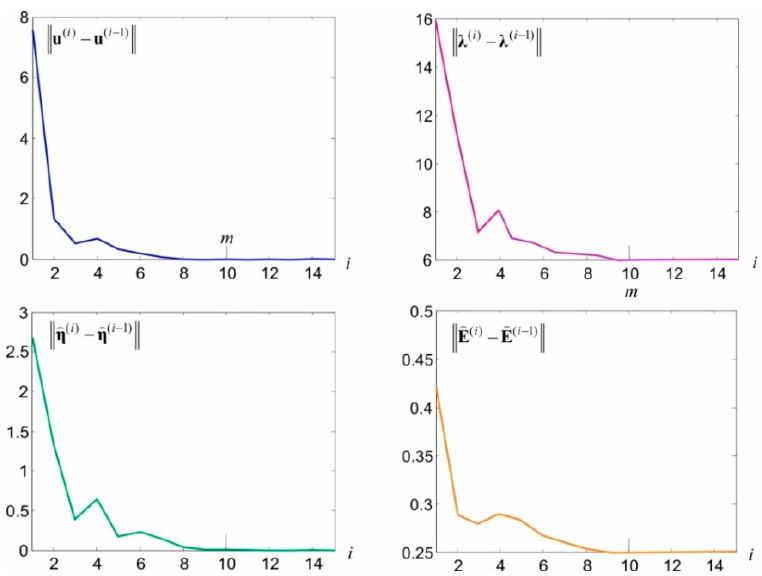
Figure 6. The course of controlled values of norms in individual iteration steps.